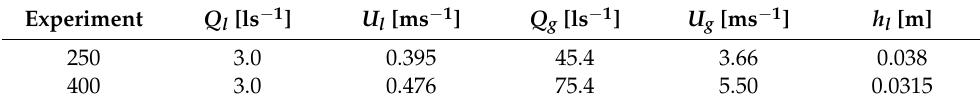
Table 1. Summary of the conditions in the experiments of Fabre et al. [30] selected for